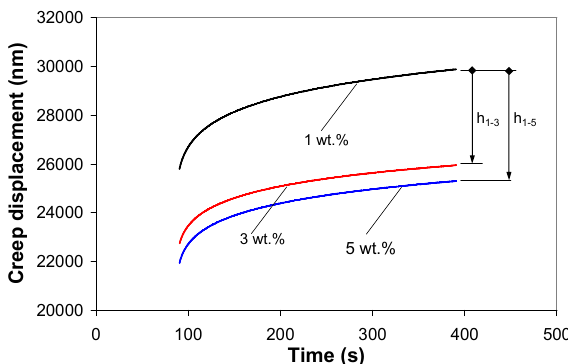
Figure 7. Indentation creep displacement curves for the PP / MWCNT nanocomposites (holding stage of the 2-cycle indentation test).